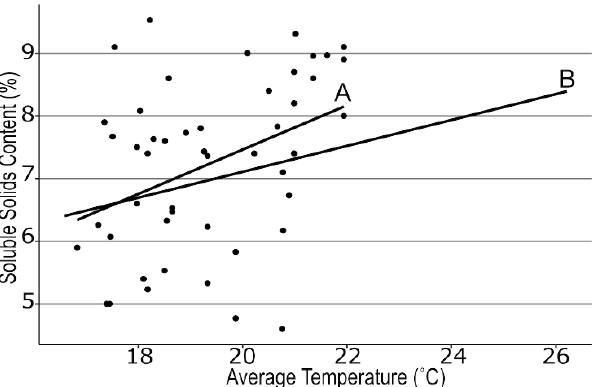
Figure 1. Regression between soluble solids content of strawberry fruit at harvest and the mean temperature between green and pink fruit (line A) and pink and red fruit (line B) for 16 farms across New York State visited in 2018, 2019, and 2020. A: y = 0.35x + 0.4, r = 0.39, p = 0.0062. B: y = 0.21x + 3.0, r = 0.36, p = 0.03.